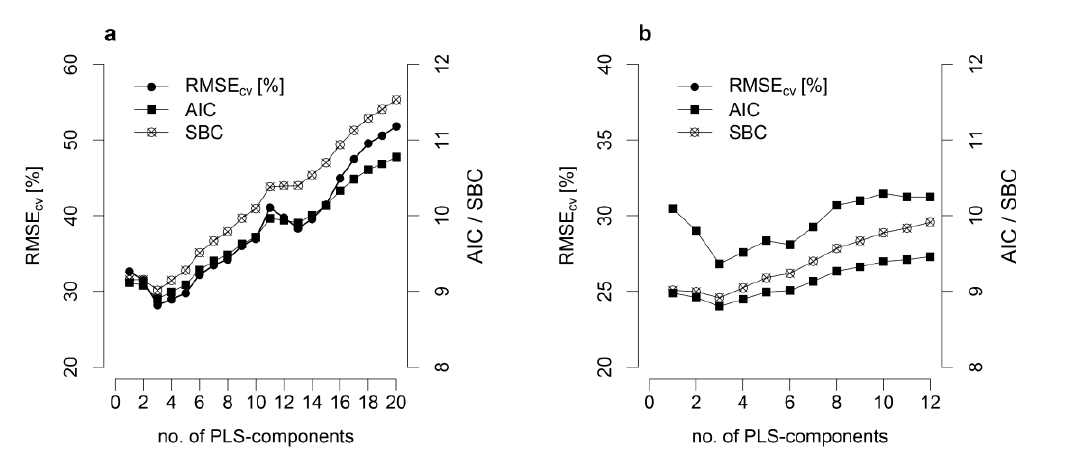
Figure 6. Loo-cv values of RMSE, AIC, and SBC for the PLSR with simulated EnMAP data ( a ) and Sentinel-2 data ( b